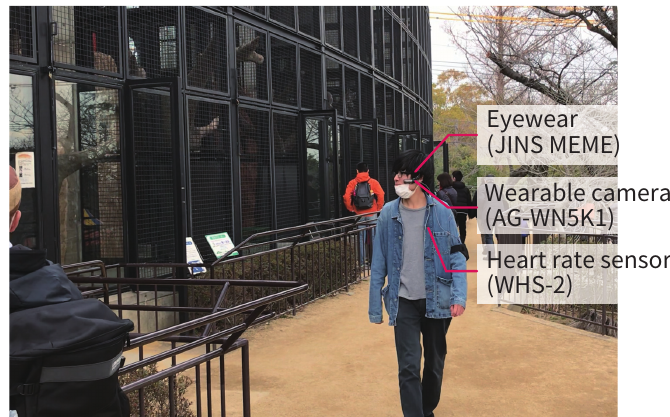
Figure 10. Appearance of a participant walking in the